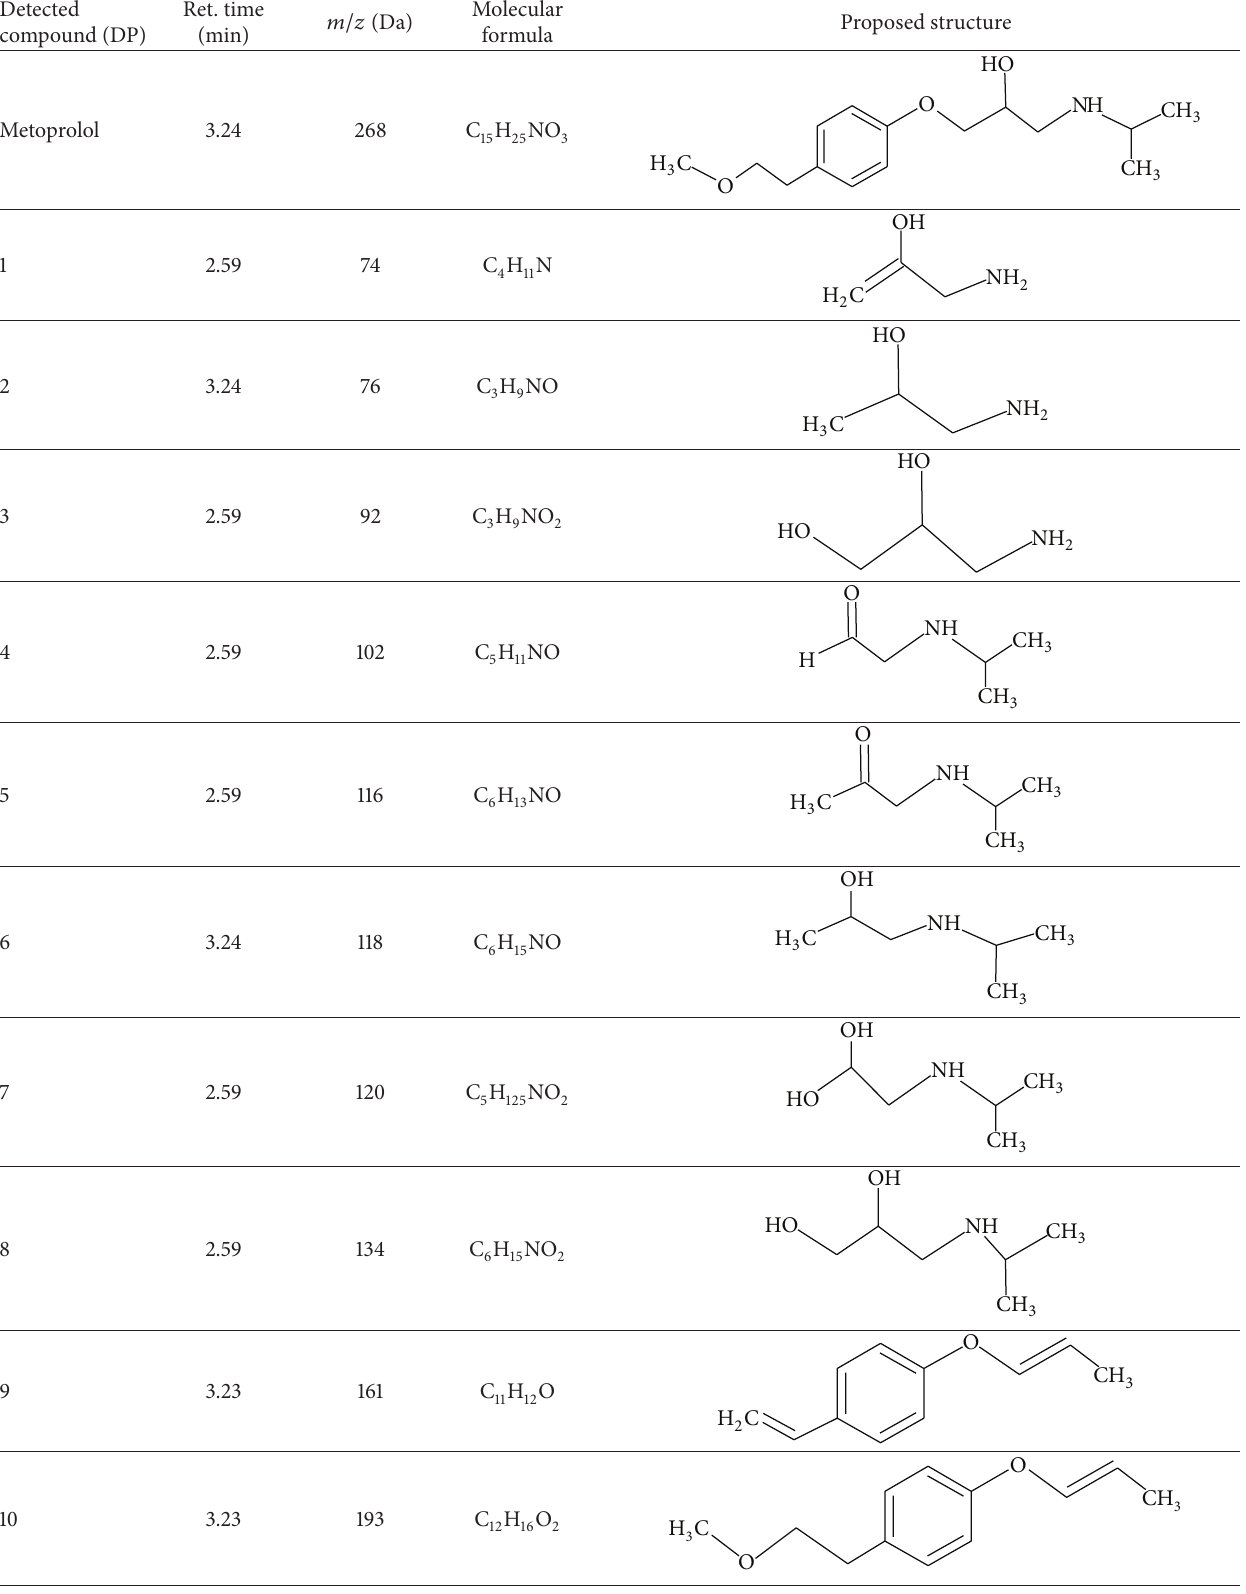
Table 3: Intermediates proposed for the photocatalytic degradation of